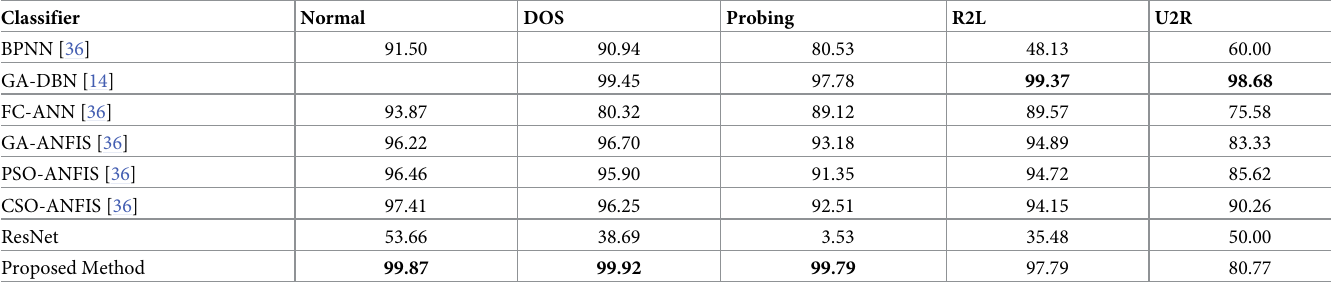
Table 8. ACC comparison of different classifiers on